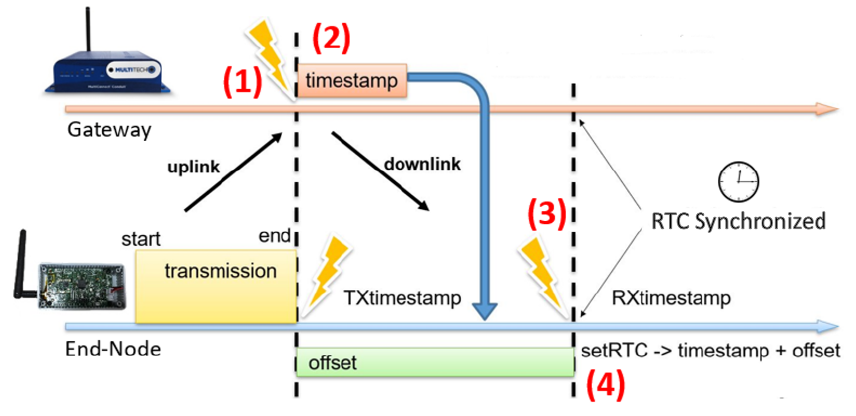
Figure 7. Synchronization procedure.